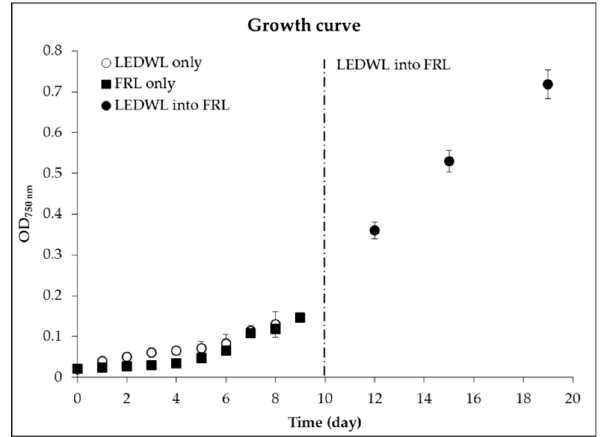
Figure 1. Growth curve, measured using optical density at 750 nm (OD 750 nm ) of Chlorogloeopsis fritschii (C. fritschii) under either light-emitting diode white light (LEDWL) or far-red light (FRL) only for 10 days. The dotted line represents the transfer of LEDWL cultures into FRL for a further 10 days.